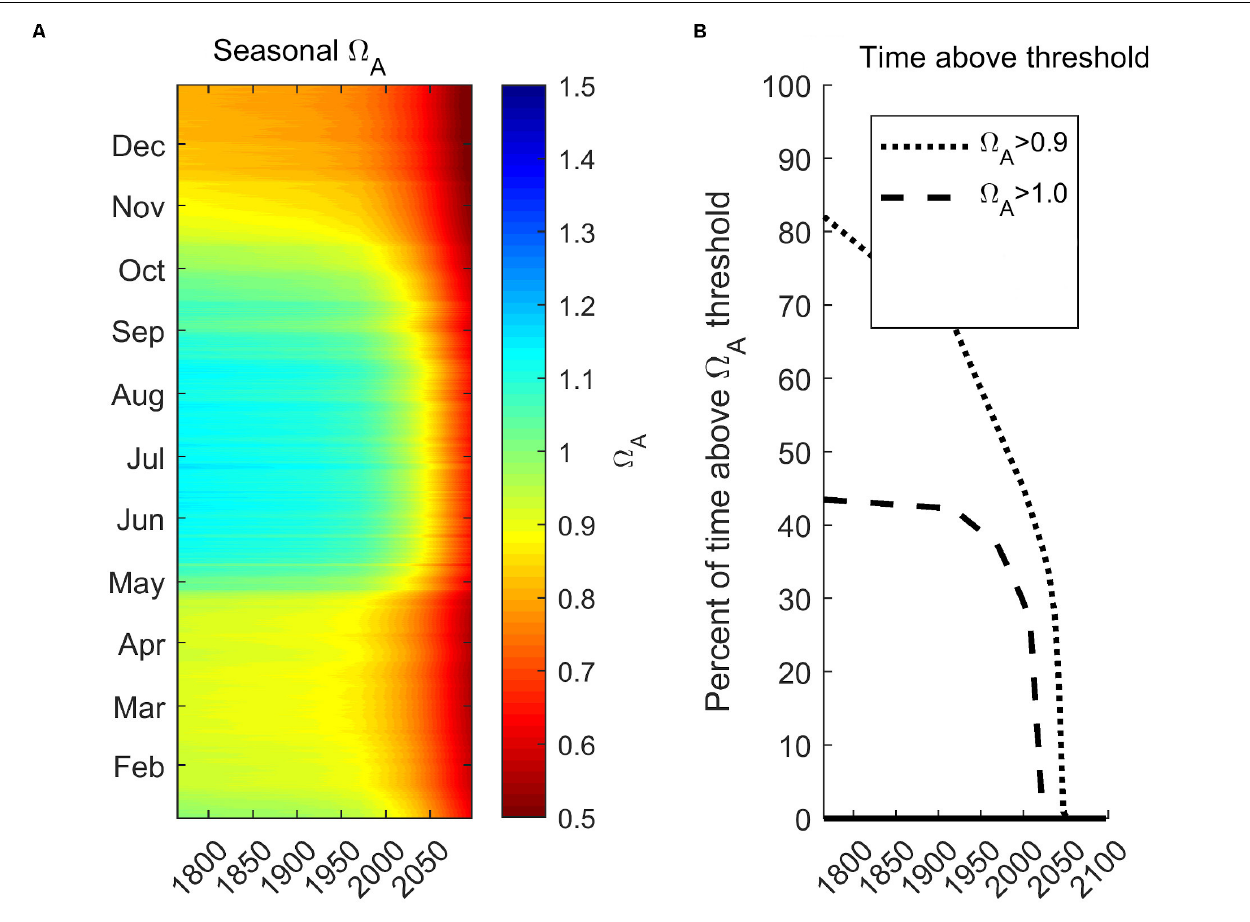
FIGURE 10 | Future seasonal projections of vertically integrated (0–100 m) (cid:127) ar at the station P28 in the Main Basin under RCP 8.5 scenario for the year 2100 (A) and projected time above pteropod thresholds for sublethal ( (cid:127) ar of 1.0) and lethal ( (cid:127) ar of 0.9; B